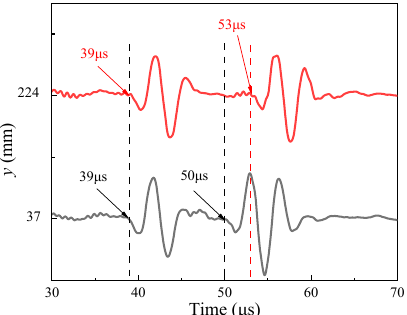
Figure 14. Arriving point extraction of reflected echo waveforms.